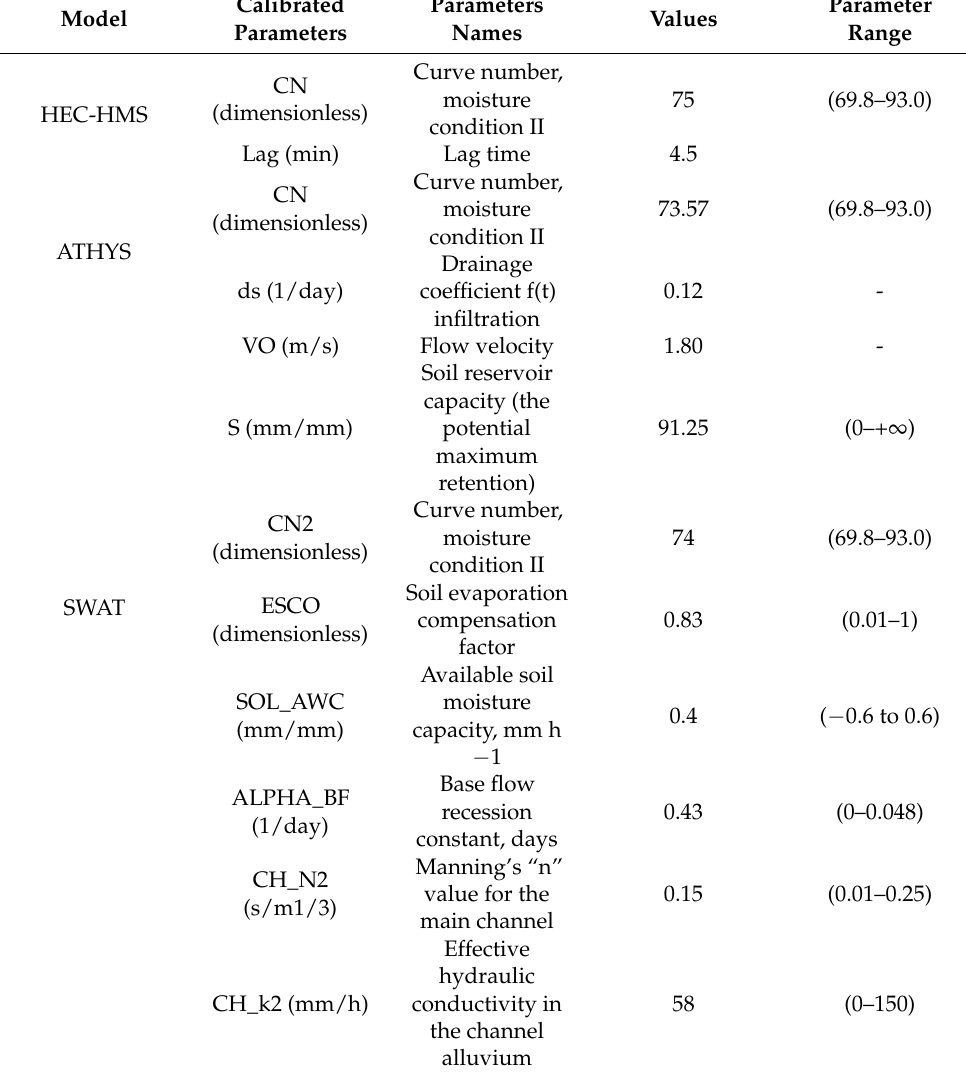
Table 1. Calibrated parameter median values for the three